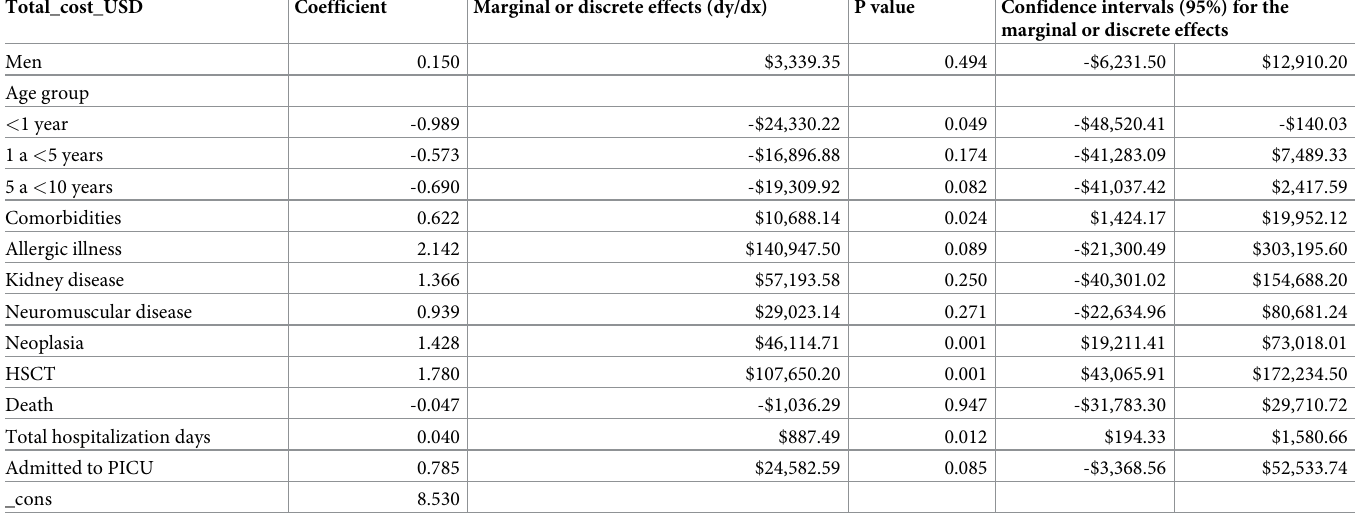
Table 7. GLM log gamma results for assessing the effect of different covariables on the new